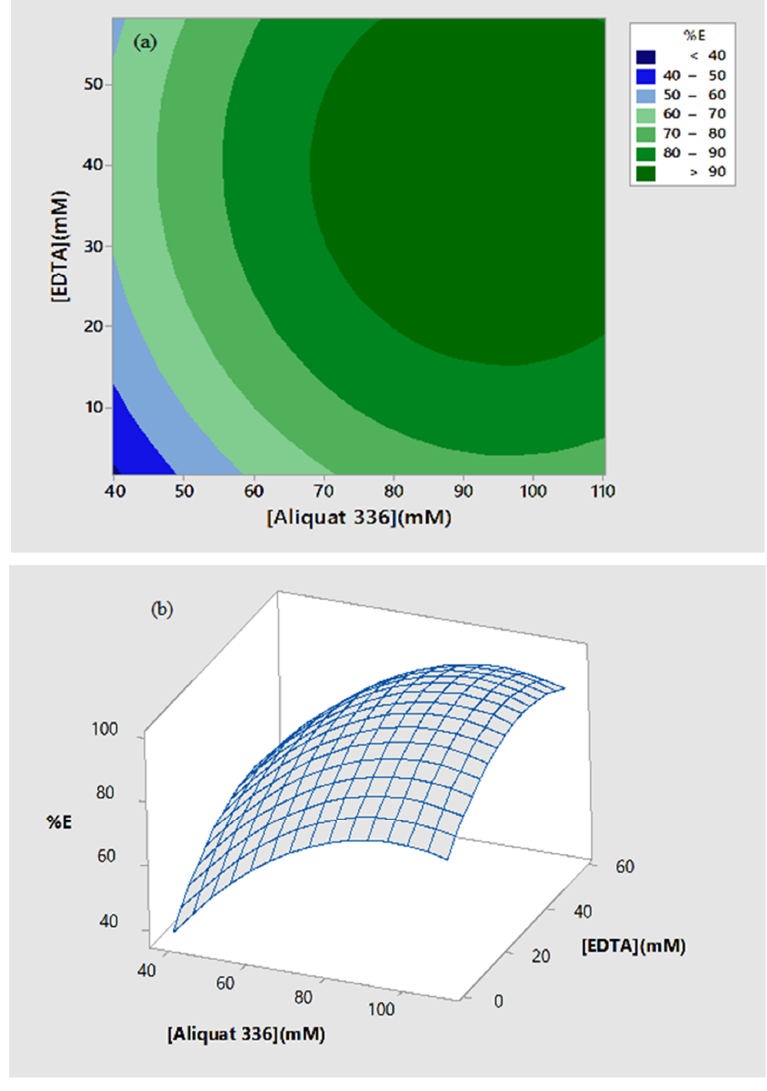
Figure 5. Response surface optimization plots of the extraction of Cd(II) ions against Aliquat 336 and EDTA in ( a ) two-dimensional contour plot and ( b ) three-dimensional response surface plot. Int. J. Mol. Sci. 2020 , 21 , x FOR PEER REVIEW The optimum conditions of factors in uncoded units (Aliquat 336 = 99.64 mM; EDTA = 48.86 mM) obtained from the optimization plot of % extraction of Cd(II) (Figure 6) generated by the Minitab software with high composite desirability (0.96531).